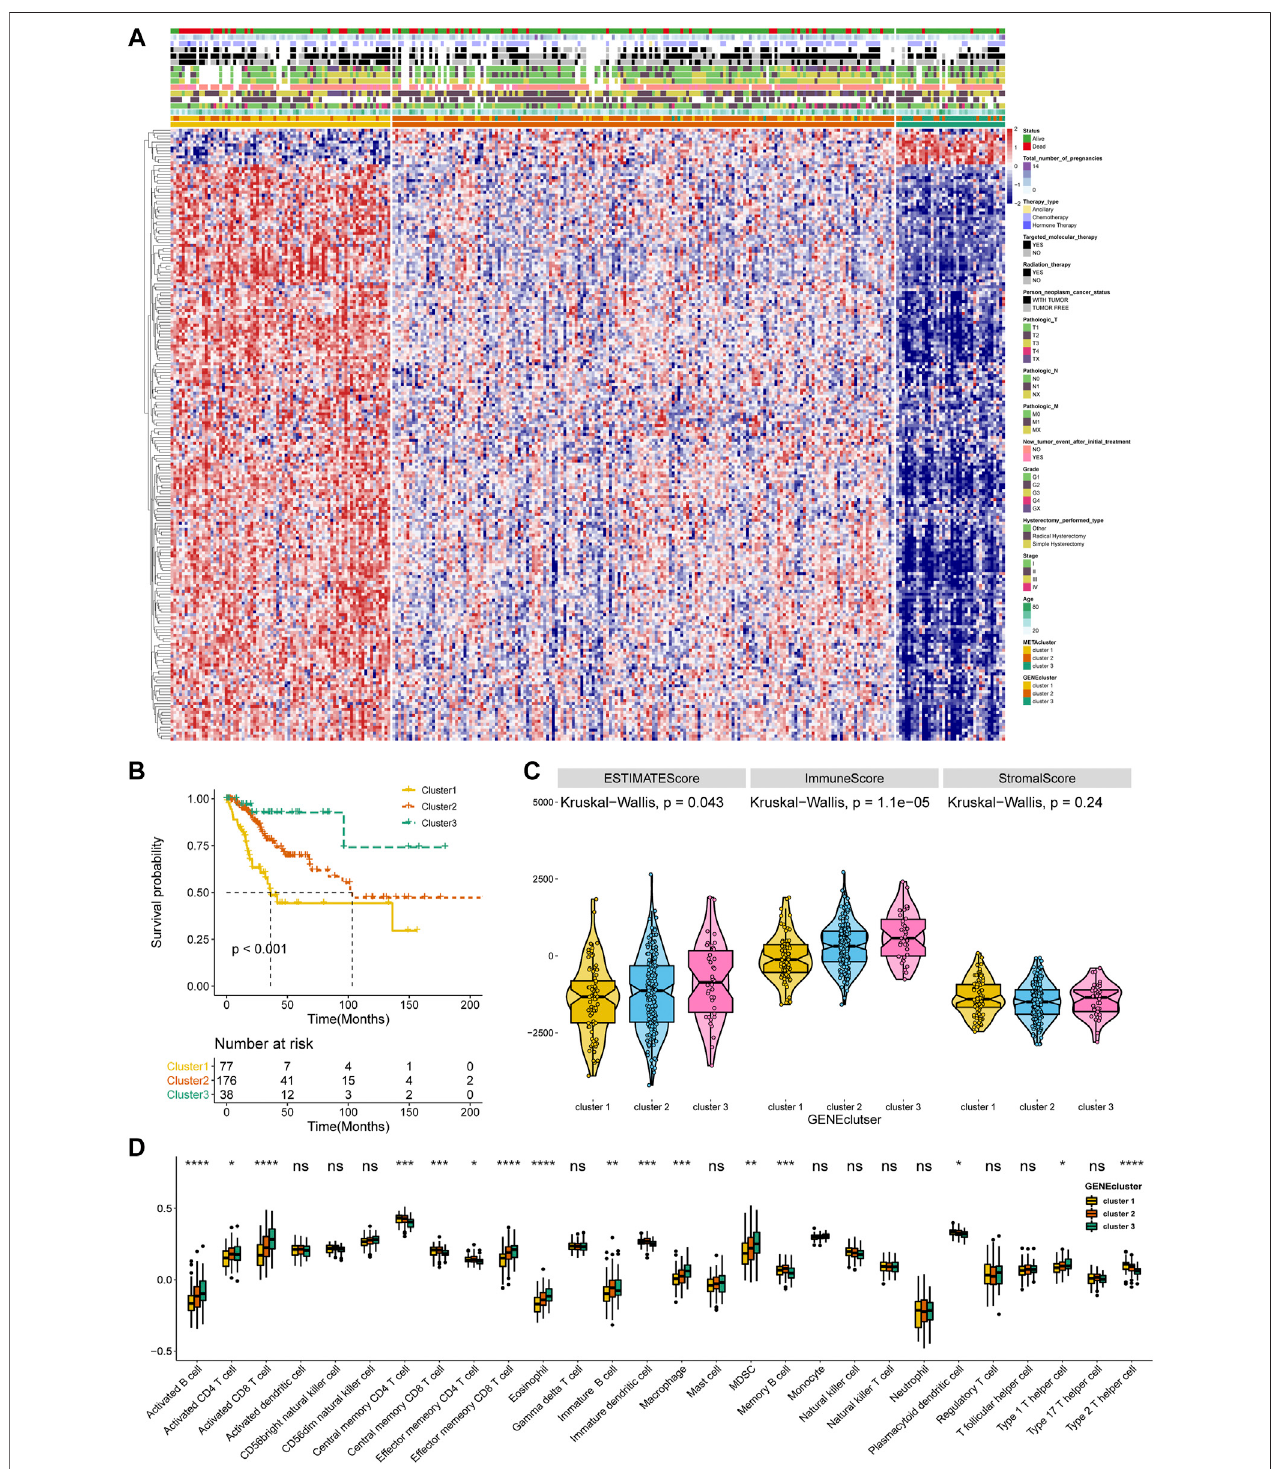
FIGURE 3 | Identi fi cation of CESC geneclusters based on DEGs of METAclusters. (A) Unsupervised clustering of CESC patients on 207 identi fi ed DGEs: genecluster 1 ( n (cid:1) 77), genecluster 2 ( n (cid:1) 176), and genecluster 3 ( n (cid:1) 38). (B) Kaplan – Meier curves for survival time of the three geneclusters in CESC. Log-rank test presented an overall p < 0.001. (C) A Violin plot showing ESTIMATE score, immune score and stromal score of the three geneclusters. (D) A Boxplot showing the abundanceofimmunecellpopulationsinthethreegeneclusters.ThestatisticaldifferencesamongthethreegeneclustersweredeterminedusingtheKruskal-Wallis test. The statistical p value was represented by asterisks (ns represents no signi fi cance; * p < 0.05; ** p < 0.01; *** p < 0.001; **** p < 0.0001).